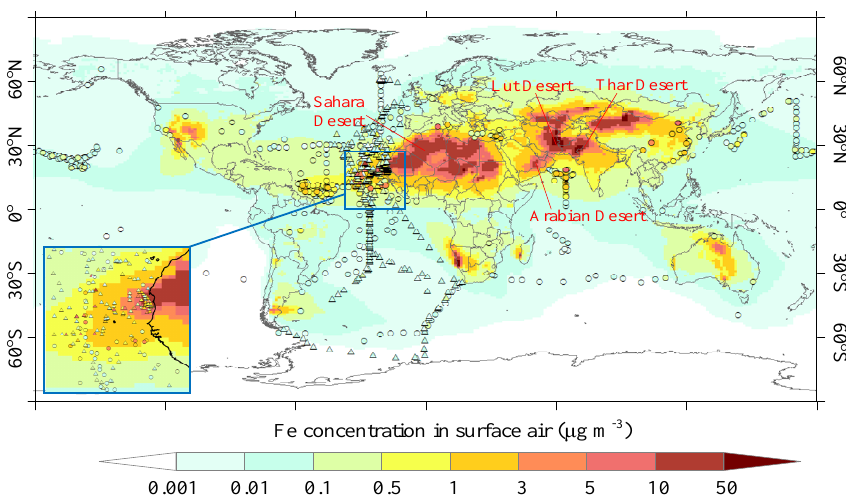
Figure 6 Figure 6. Distribution of annual mean concentrations of Fe attached to aerosols in surface air. A total of 529 measured Fe concentrations compiled by Mahowald et al. (2009) and Sholkovitz et al. (2012) and collected in this study (Table S3) are shown as circles, and a total of 296 Fe concentrations measured by Baker et al. (2013) over the Atlantic Ocean are shown as triangles.